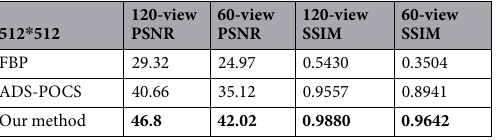
Table 3. Average values of PSNR and SSIM between proposed method and full-view FBP reconstruction for 512 * 512 CT images.